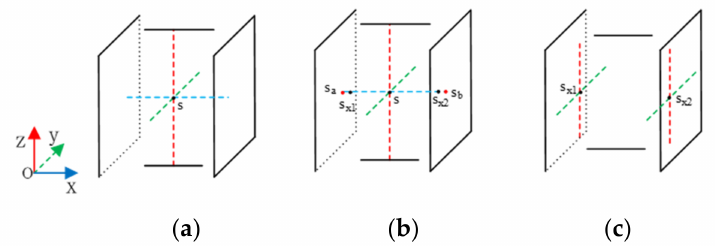
Figure 7. ( a )The source point S stop the elongation for encountering obstacles (lines or planes). ( b ) Coordinate selection of the escape point. ( c ) The extension of new escape